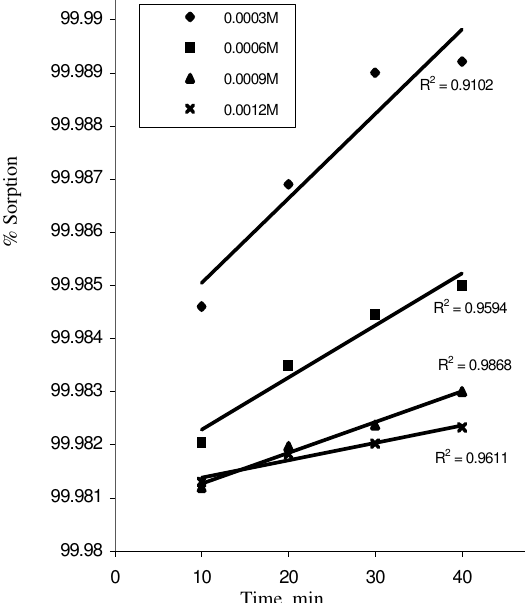
Figure 1 . Variation of % of Pb adsorbed by snail shell with time.